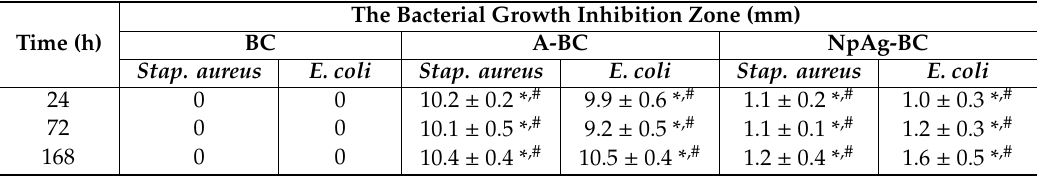
Table 8. Bacterial growth inhibition for untreated SLM titanium alloy specimens coated with bone cements (n = 3; data are the means ± SD; * significantly different from control (p < 0.050; # significantly different between modifications (p < 0.05)).